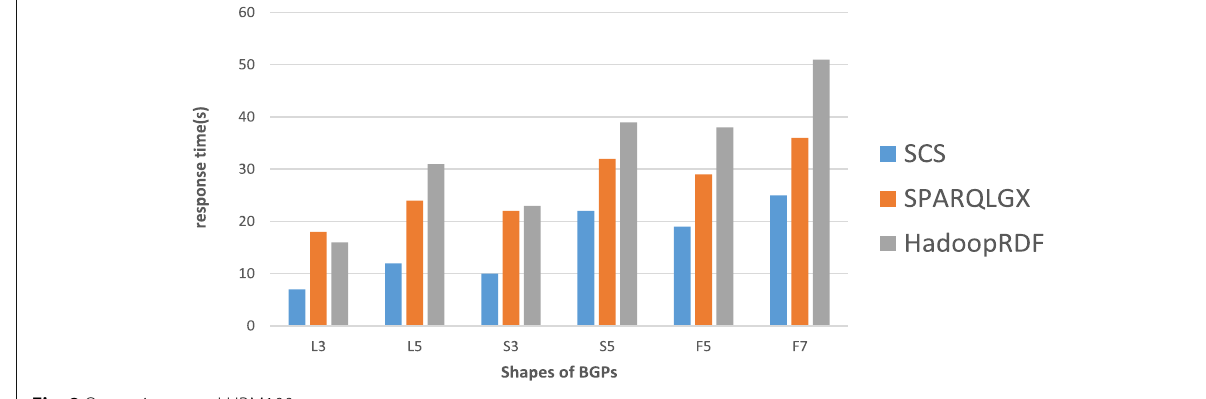
Fig. 8 Query time over LUBM100